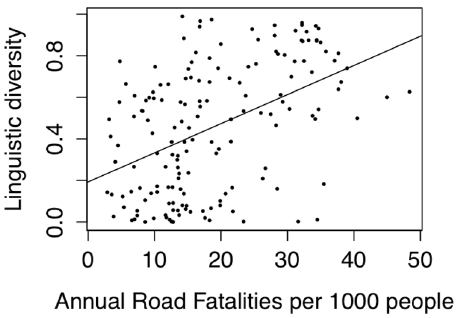
Figure 2. Linguistic diversity and traffic accidents. Countries’ linguistic diversity (Greenberg diversity index) as a function of the annual traffic fatalities per 1000 people, with linear regression line.